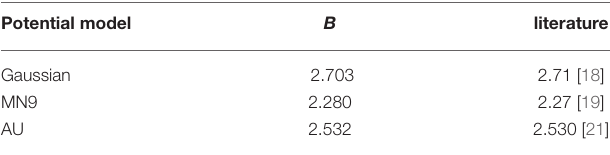
TABLE 14 | The 3 3 H binding energy B (in MeV) obtained in the present work is compared with the results present in the